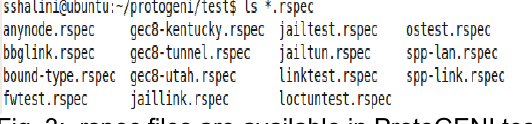
Fig. 3: .rspec files are available in ProtoGENI test scripts suite